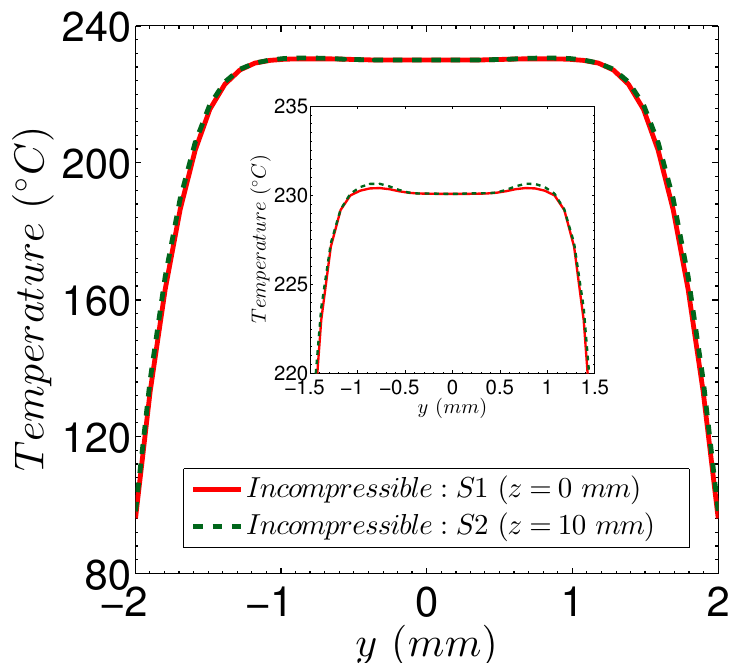
Figure 6: Temperature profiles across channel thickness at slices S1 and S2, using the Figure 6. Temperature profiles across the channel thickness at slices S1 and S2, using the incompressible incompressible formulation. formulation, for Case Study 2. minimum value of the velocity field magnitude is not presented in Table 9 Table 8. Minimum, average, and maximum temperature values for slices S1 and S2 (see Figure 4), because on the mould walls the no-slip boundary condition is applied for the at the switch-over point. velocity field. From the results shown in Tables 8 and 9 we conclude that the differences between the compressible and incompressible formulations in both velocity and temperature fields are negligible, i . e , smaller than 4%.